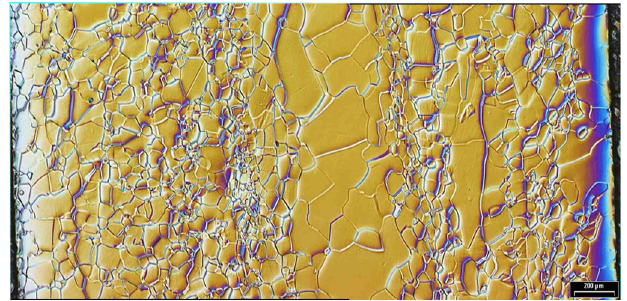
FIG. 23. Microstructure of the back extruded niobium tube with RRR300.